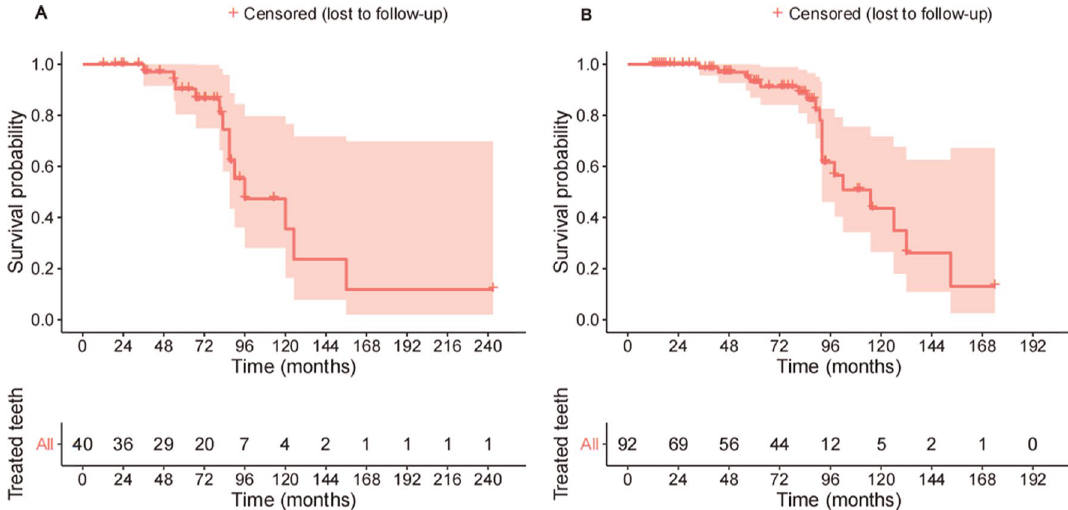
Figure 1. Kaplan–Meier survival curve for the entire follow-up period for the OFD ( A ) and the SRP ( B ) groups. Each event represents a tooth loss. The reddish hue represents the upper and lower limit of the 95% confidence